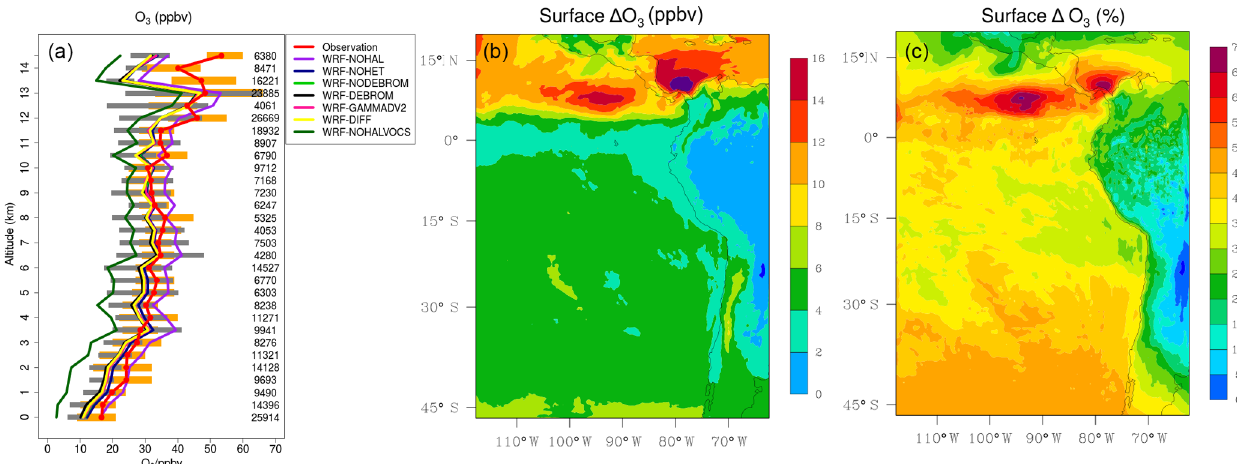
Figure 13. (a) Mean vertical profile of O 3 (ppbv) over the domain area using 13 flights from the TORERO campaign (red line) compared to the seven different WRF-Chem simulations: WRF-NOHAL (purple line), WRF-NOHET (blue line), WRF-NODEBROM (light green line), WRF-DEBROM (black line), WRF-GAMMADV2 (pink line), WRF-DIFF (yellow line) and WRF-NOHALVOCS (dark green line). Orange and grey horizontal bars indicate the 25th–75th quartile interval for the observations of the TORERO campaign and WRF-DEBROM simulation, respectively. Values are considered in 0.5km bins and the number of aircraft measurement points for each altitude is given on the right side of each plot. (b, c) Mean O 3 difference between the simulation with no halogen chemistry (WRF-NOHAL) and with halogen chemistry (WRF-DEBROM) for January and February 2012. Surface mean bias (ppbv) is shown in panel (b) and surface relative mean bias (%) in panel (c) . Relative mean bias (%) is calculated as (WRF-NOHAL − WRF-DEBROM) / WRF-NOHAL × 100.